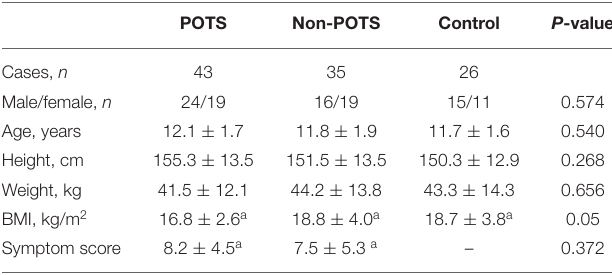
TABLE 1 | Demographic characteristics and symptom score of the POTS, non-POTS, and control groups.